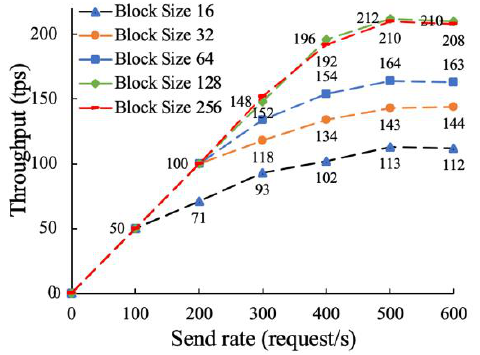
Figure 13. The effect of block size on the throughput performance of the on-chain function.